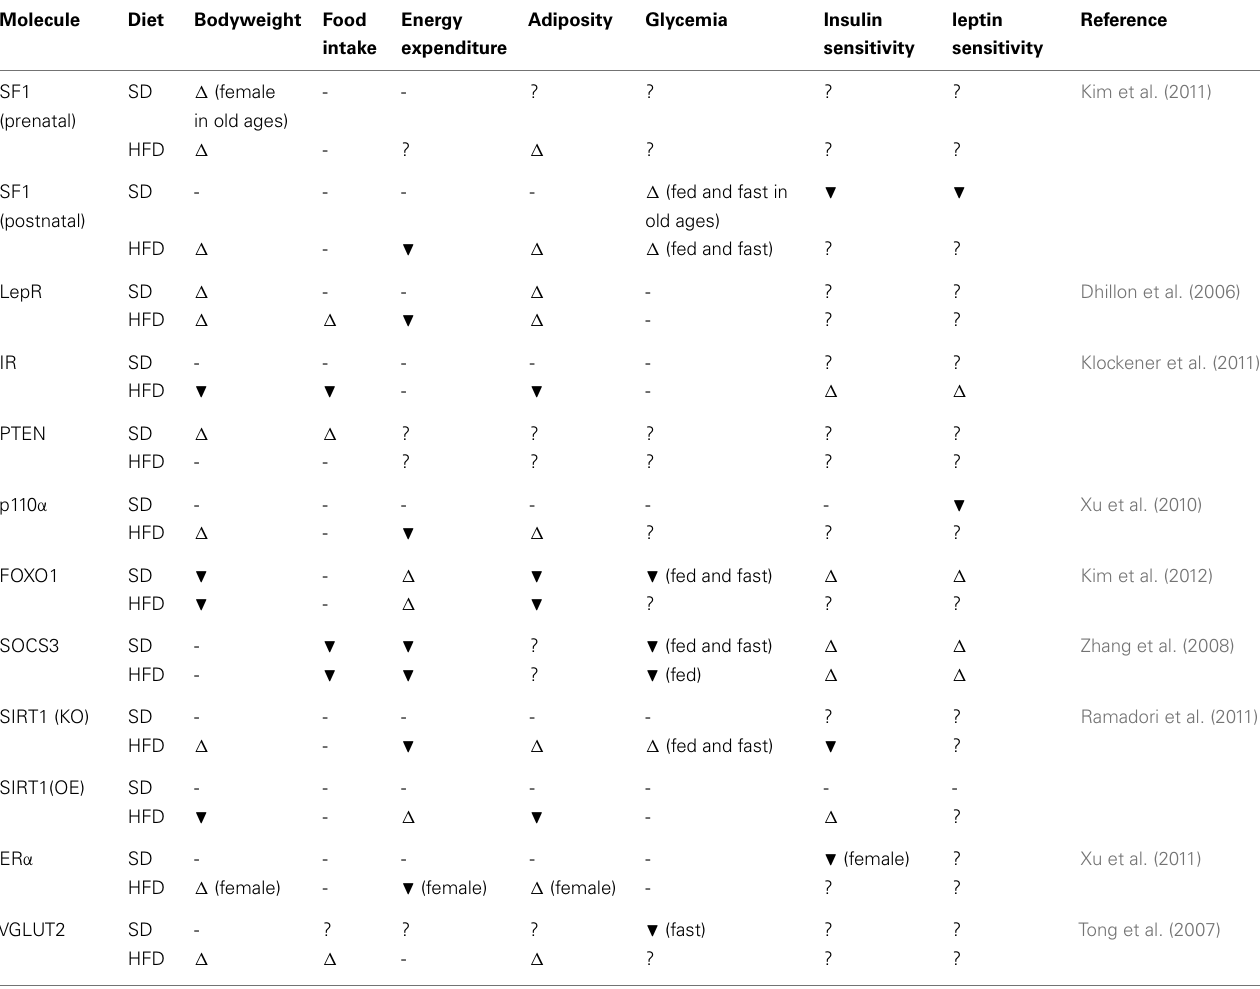
Table 1 | Gene manipulation specifically in SF-1 neurons affects energy and glucose homeostasis. Molecule Diet Bodyweight Food Energy Adiposity intake expenditure